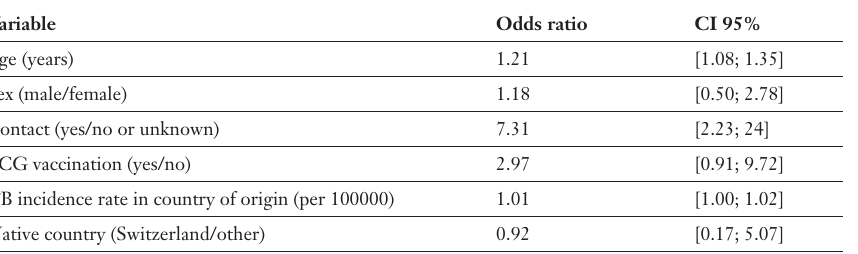
Table 3 Logistic regression analysis of risk factors for positive Tuberculin Skin